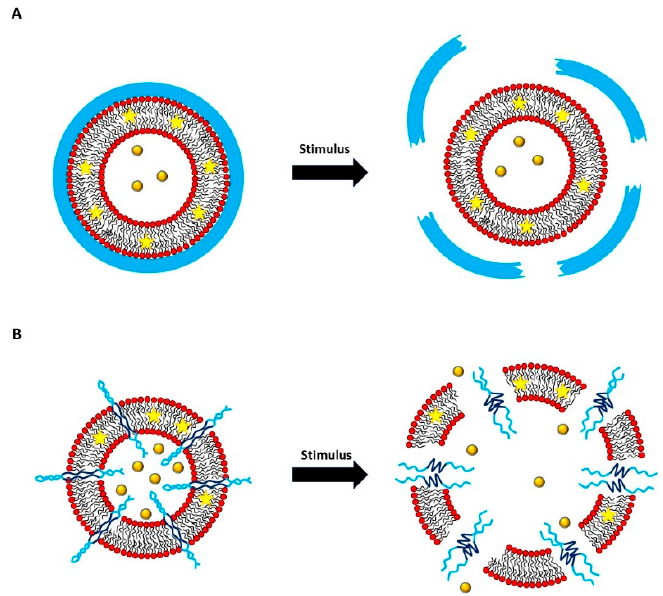
Figure 8. Stimuli-responsive polymeric coatings of liposomes. In ( A ), the stimulus dissolves the protecting coating, while in ( B ), the stimulus destabilizes the bilayer and/or induces the formation of transmembrane channels.